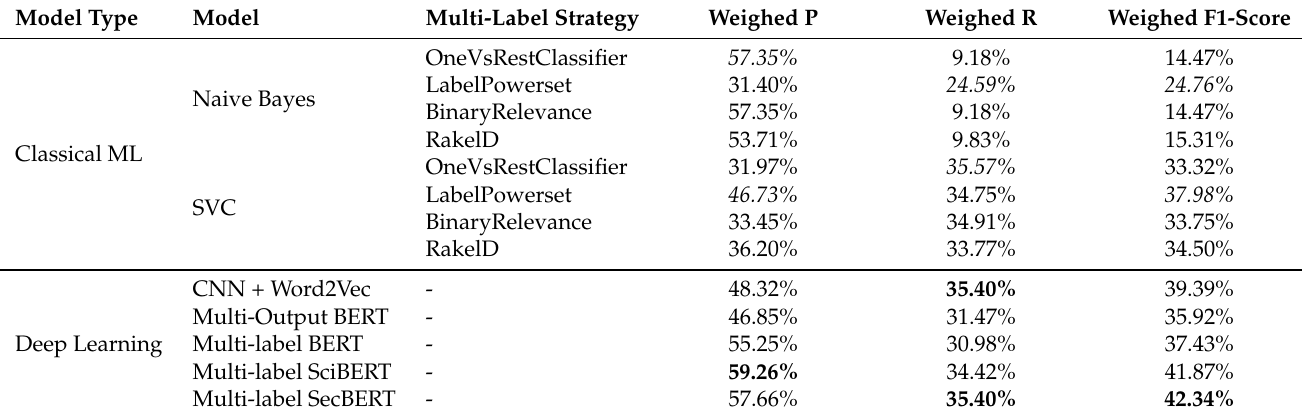
Table 1. Results for the proposed models (italics marks the best multi-label strategy for classical ML, while bold marks the best